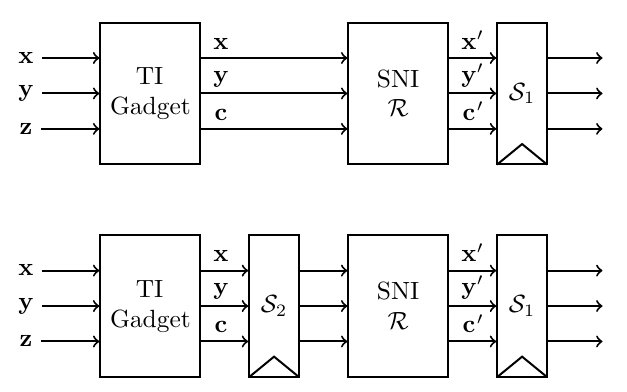
Figure 5: Examples of non-complete and SNI gadgets that do not compose in the robust probing model (independent of the synchronization stages /